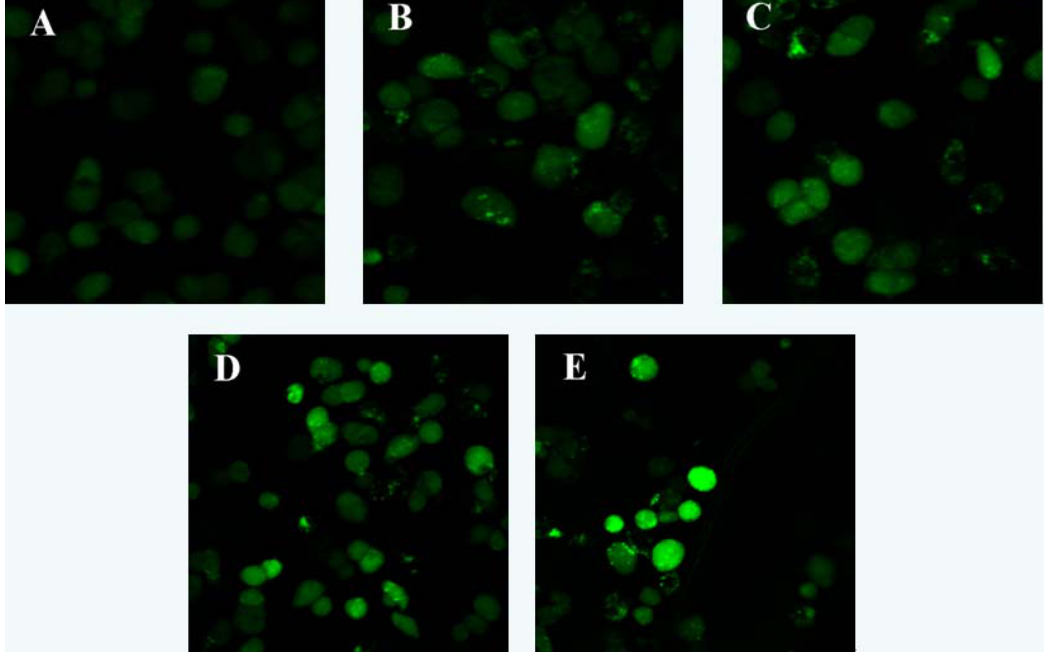
Figure 4. Effects of laminarin on intracellular fluorescent intensity of [Ca 2+ ] in LOVO. ( A ) Cells were treated as control group; ( B ) Cells were treated with 400 µg · mL − 1 laminarin; ( C ) Cells were treated with 800 µg · mL − 1 laminarin; ( D ) Cells were treated with 1,600 µg · mL − 1 laminarin; ( E ) Cells were treated with 5 µg · mL − 1 HCPT.